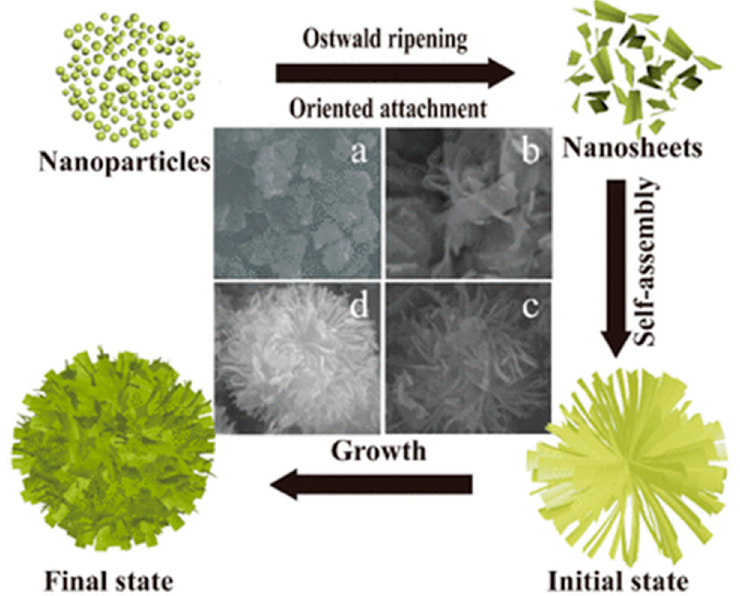
Figure 7. Schematic illustration of the growth evolution mechanism for 3D flower-like TiO 2 microspheres self-assembled by nanoplates using the hydrothermal method at different time: ( a ) 3 h; ( b ) 6 h; ( c ) 9 h; ( d ) 12 h. TiO 2 NPs after the nucleation begins to grow in the direction of orientation, forming nanosheets after dehydration. With the increasing of hydrothermal time (at 400 °C), the nanosheets are self-assembled to form a 3D flower-like structure as final state. Reproduced with permission from [69]. Copyright © 2018 Springer Nature.